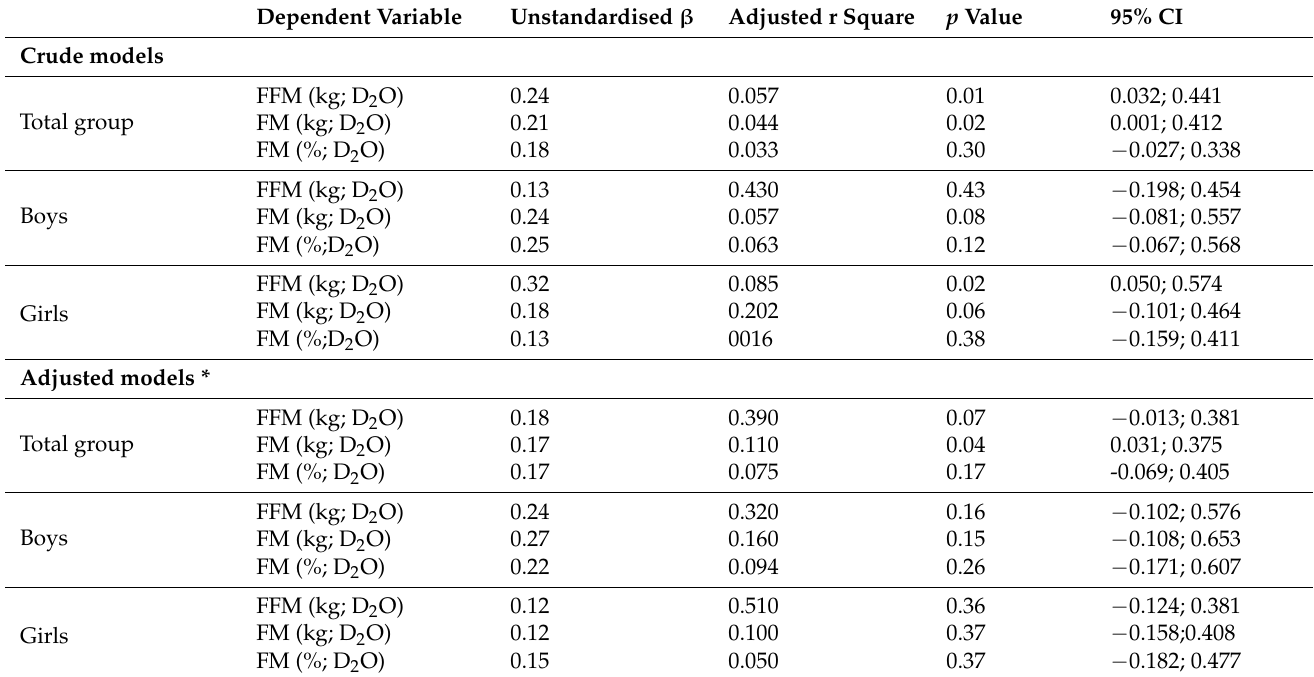
Table 5. Multiple regression analyses of correlates of BW (independent variable) and FFM, FM, and FM% (dependent